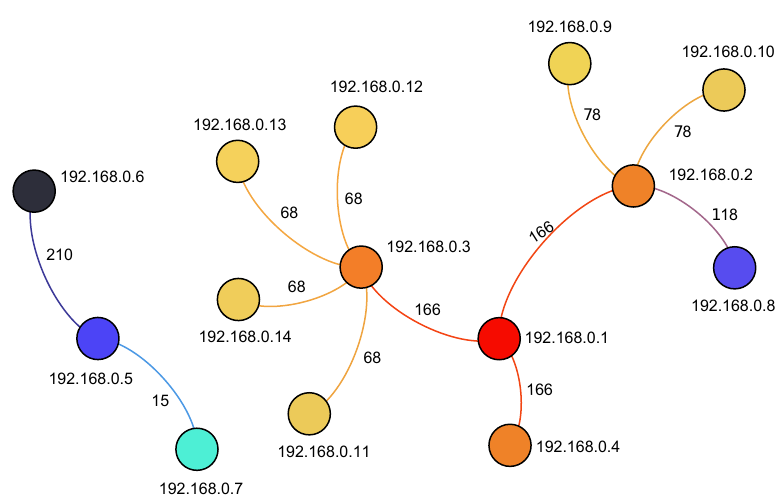
Figure 6. An illustrative example of our proposed